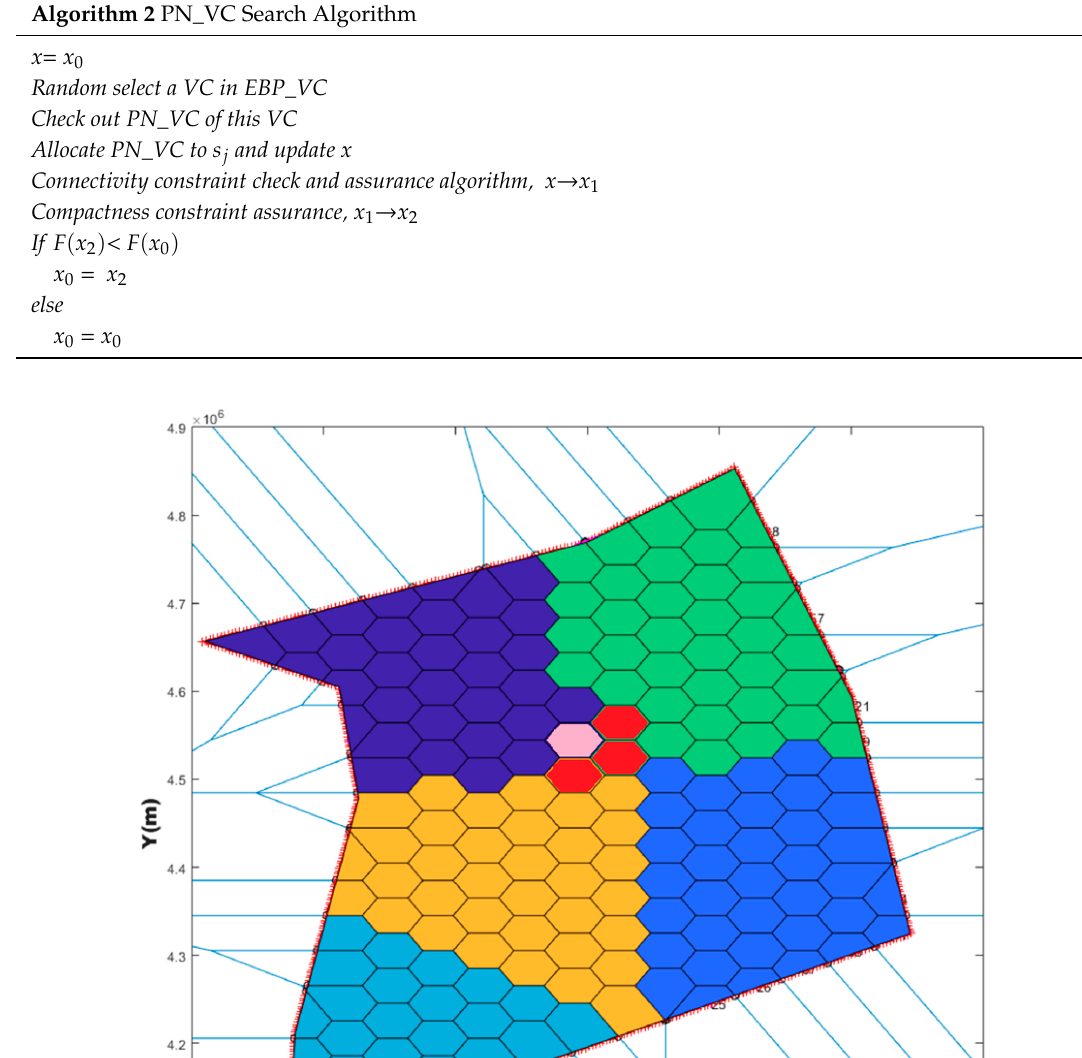
Algorithm 2, PN_VC search algorithm: